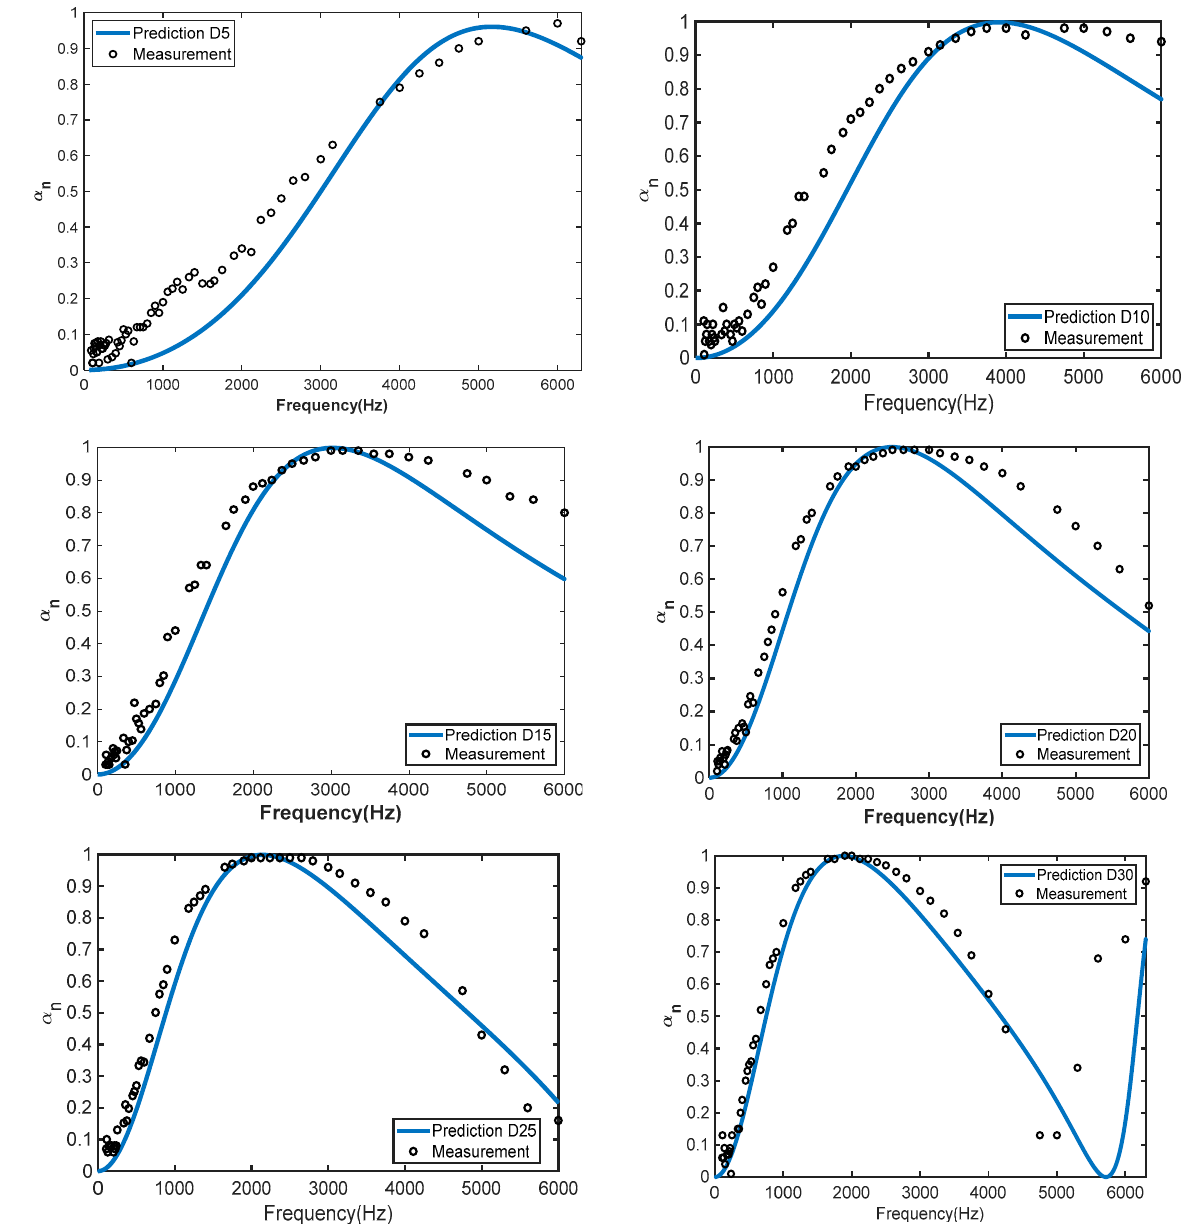
Figure 11 . Sound absorption comparison results between Maa’s model and the measurement results for woven fabric S7 with variation air cavity depth of 5–30 mm (D5–D30)